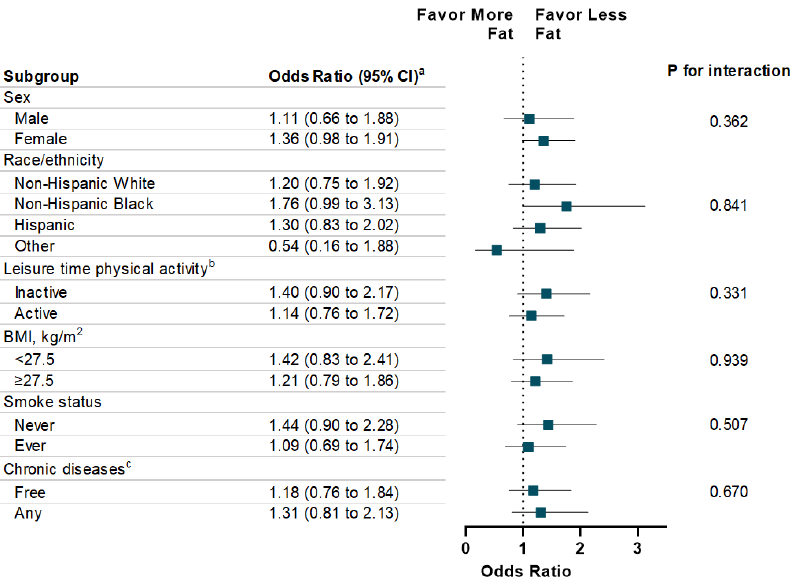
Figure 3. Stratification Analysis on Association Between Energy Intake from Fat and Memory Impairment Among US Adults ≥60 years, NHANES 2011–2014. a Multivariable models were adjusted for age, sex, race/ethnicity, education attainment, and family poverty ratio, physical activity, HEI-2010, alcohol intake, BMI, Body Weight, smoking status, hypertension, hypercholesterolemia, family history of diabetes, history of CVD, and history of cancer. b Leisure-time physical activity level was defined by engaging in no (inactive) or any (active) moderate or vigorous recreational physical activity over the past 30 days. c Chronic Diseases included diabetes, CVD, and Cancer.